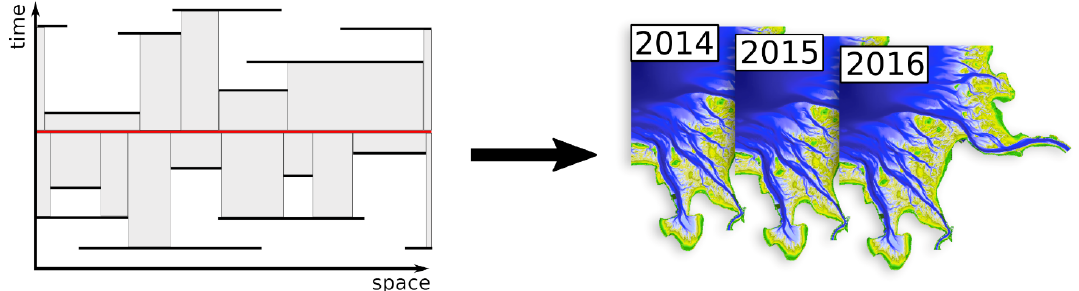
Figure 4. Concept of spatiotemporal interpolation of bathymetric